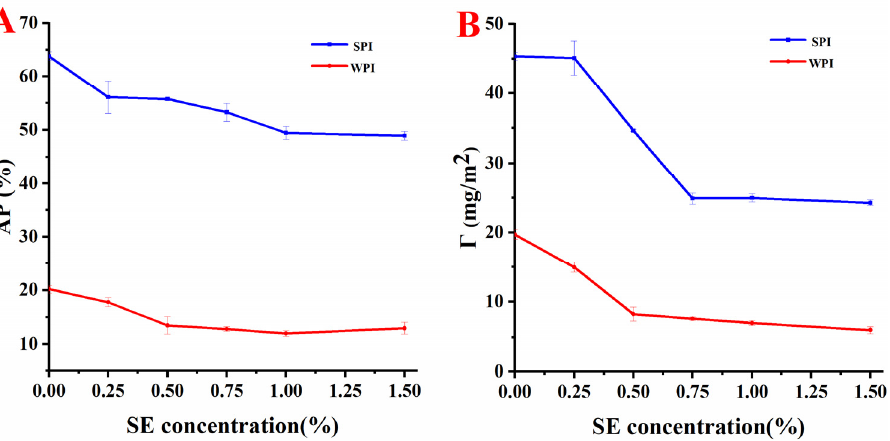
Figure 1. The interfacial protein loading rate (AP%) and interfacial protein concentration ( Γ ) of the emulsions at different concentrations of SE (( A ): AP%; ( B ): Γ ). emulsions at different concentrations of SE (( A ): AP %; ( B ): Γ